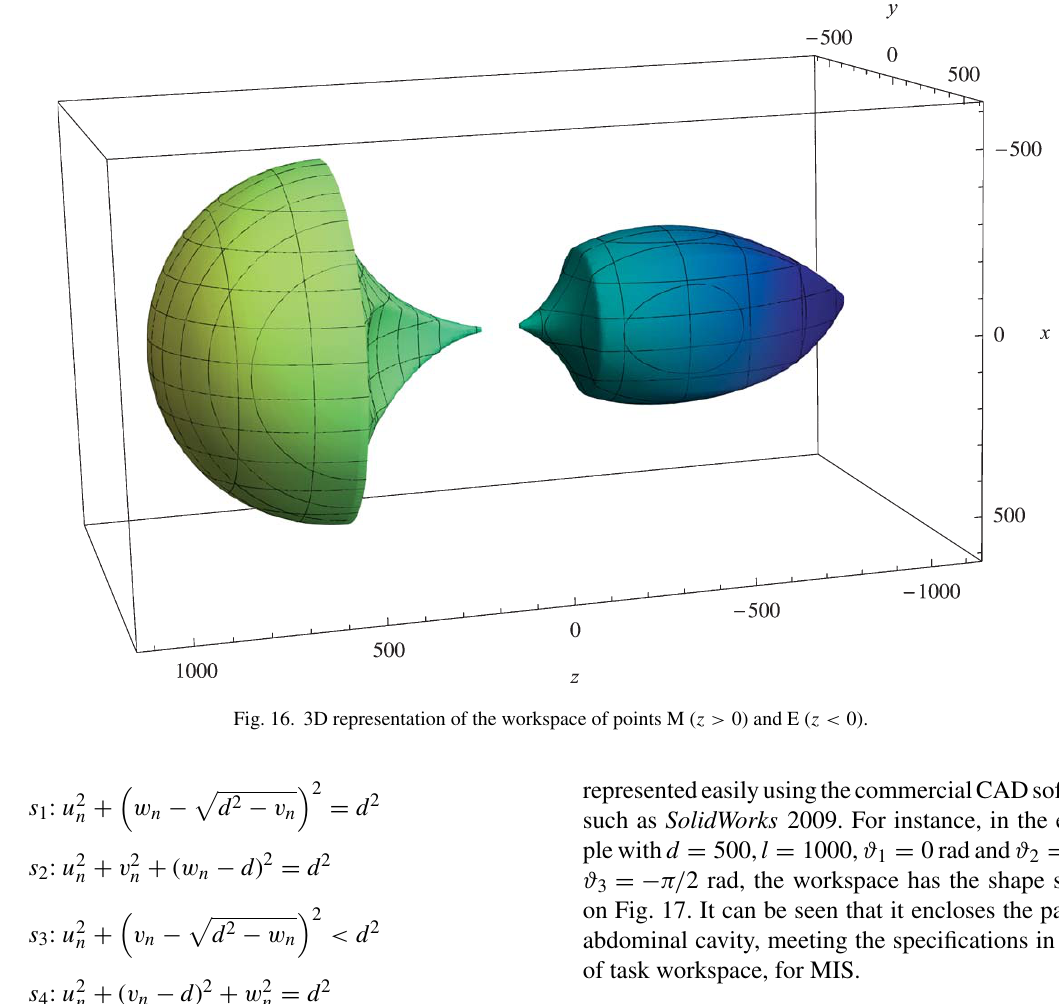
Fig. 16. 3D representation of the workspace of points M ( z > 0) and E ( z <